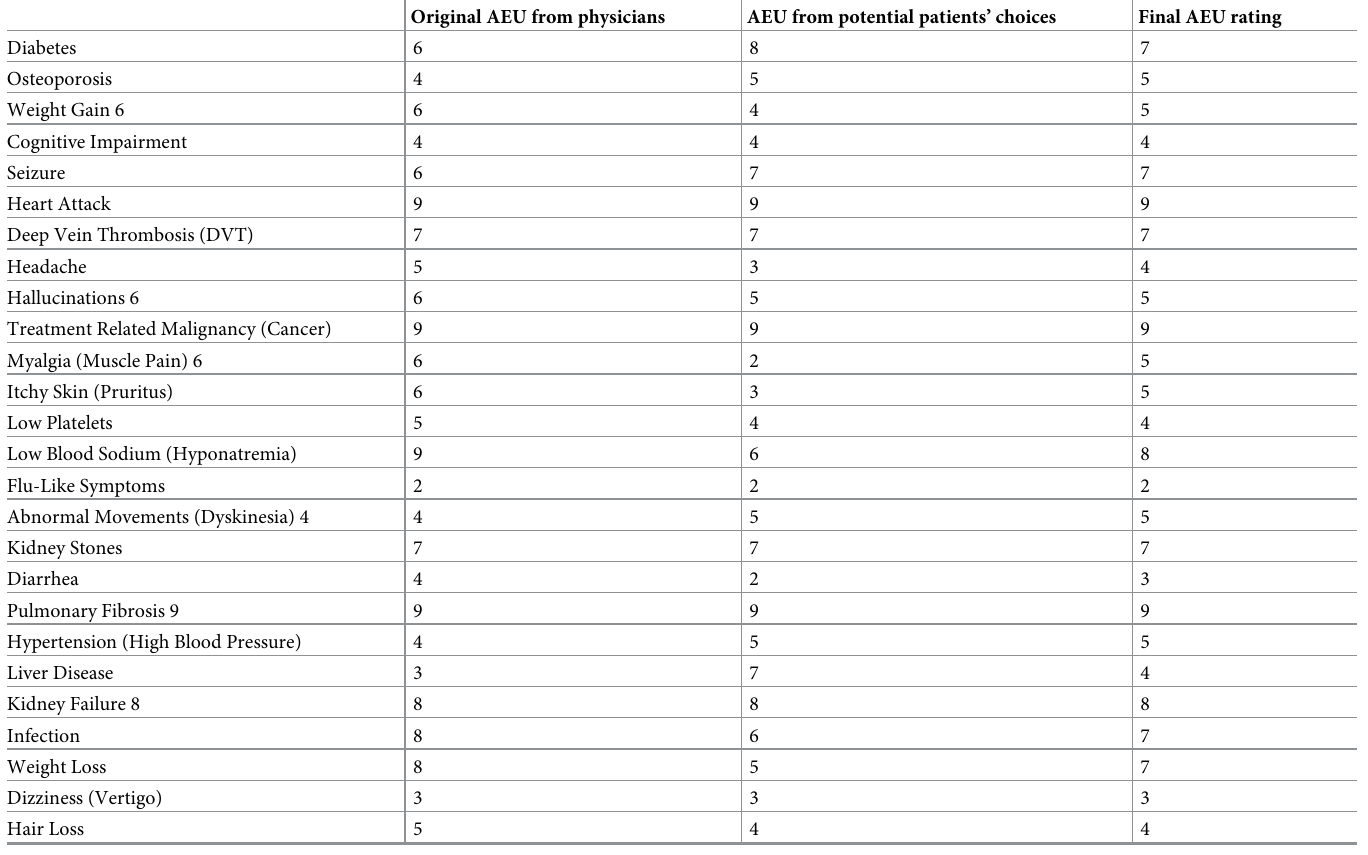
Table 3. Combined physician and potential patient AEU